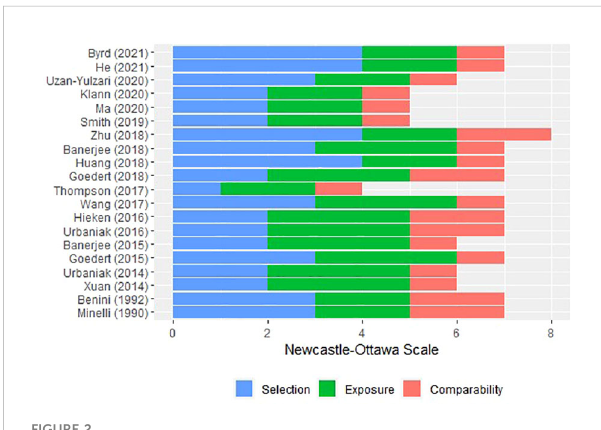
FIGURE 2 Risk of bias of the included case-control studies via Newcastle – Ottawa